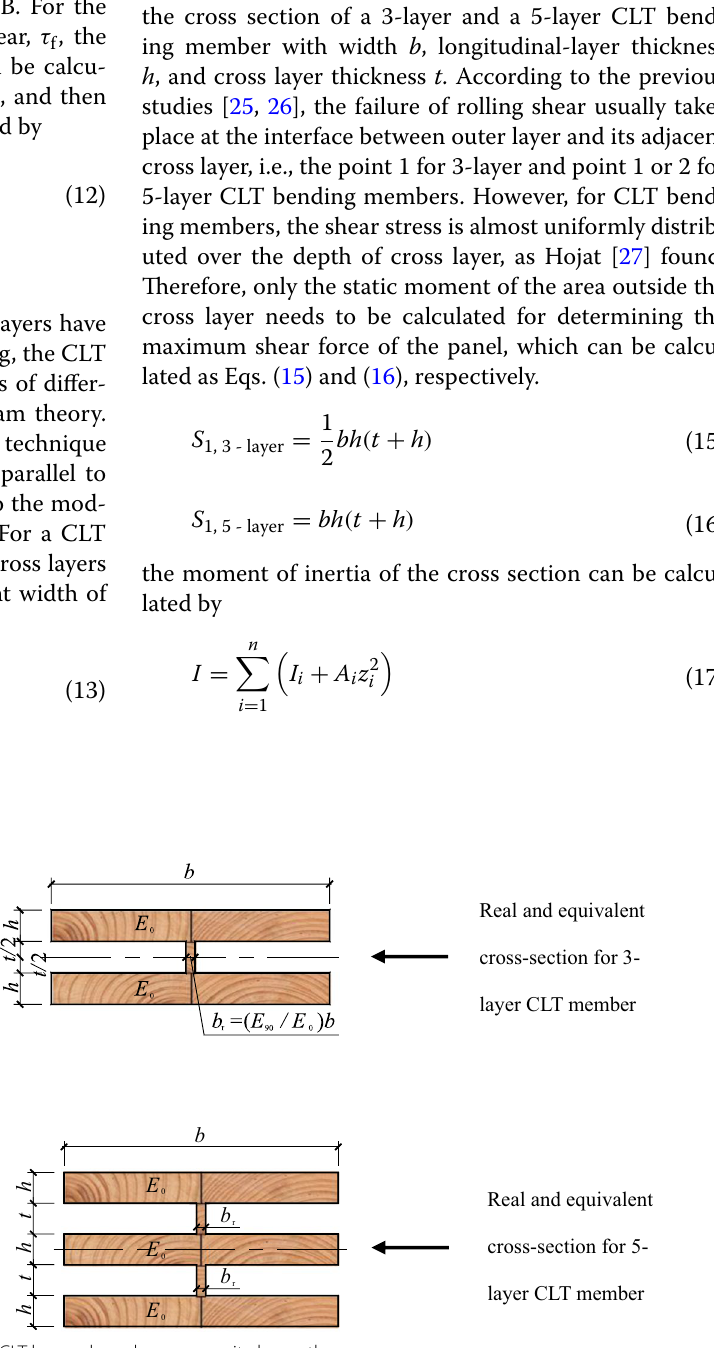
Fig. 1 Equivalent cross section for 3-layer and 5-layer of a CLT beams based on composite beam